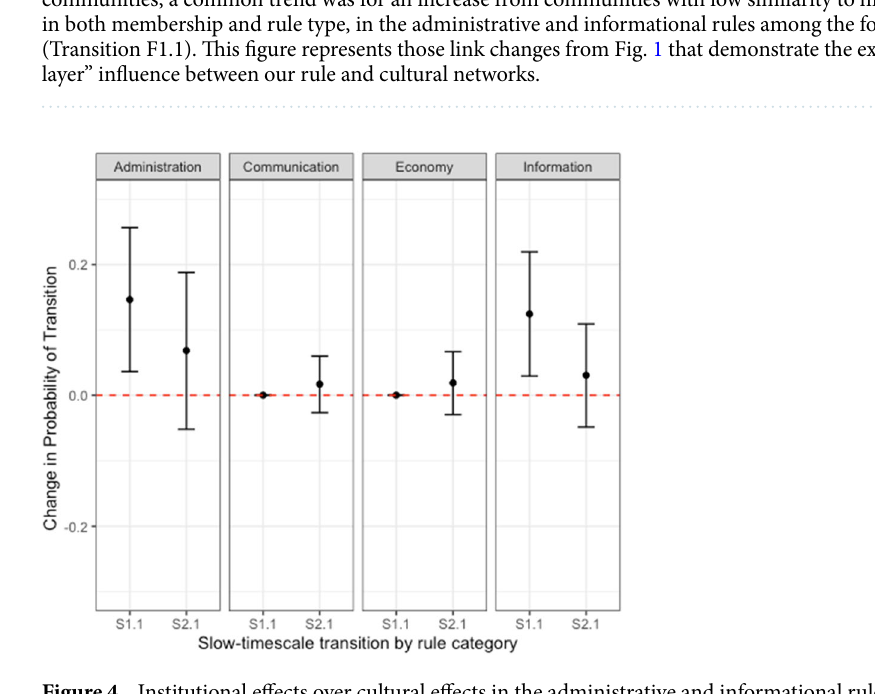
Figure 4. Institutional effects over cultural effects in the administrative and informational rule category. We test the effects between institution and culture for all four rule types, finding influence from institutional to cultural similarity (The relationship shown in this figure is repeated in the first panel to provide an aid to comparison). We produce the same effect for administrative and informational rules, but find no effect for communication or economic